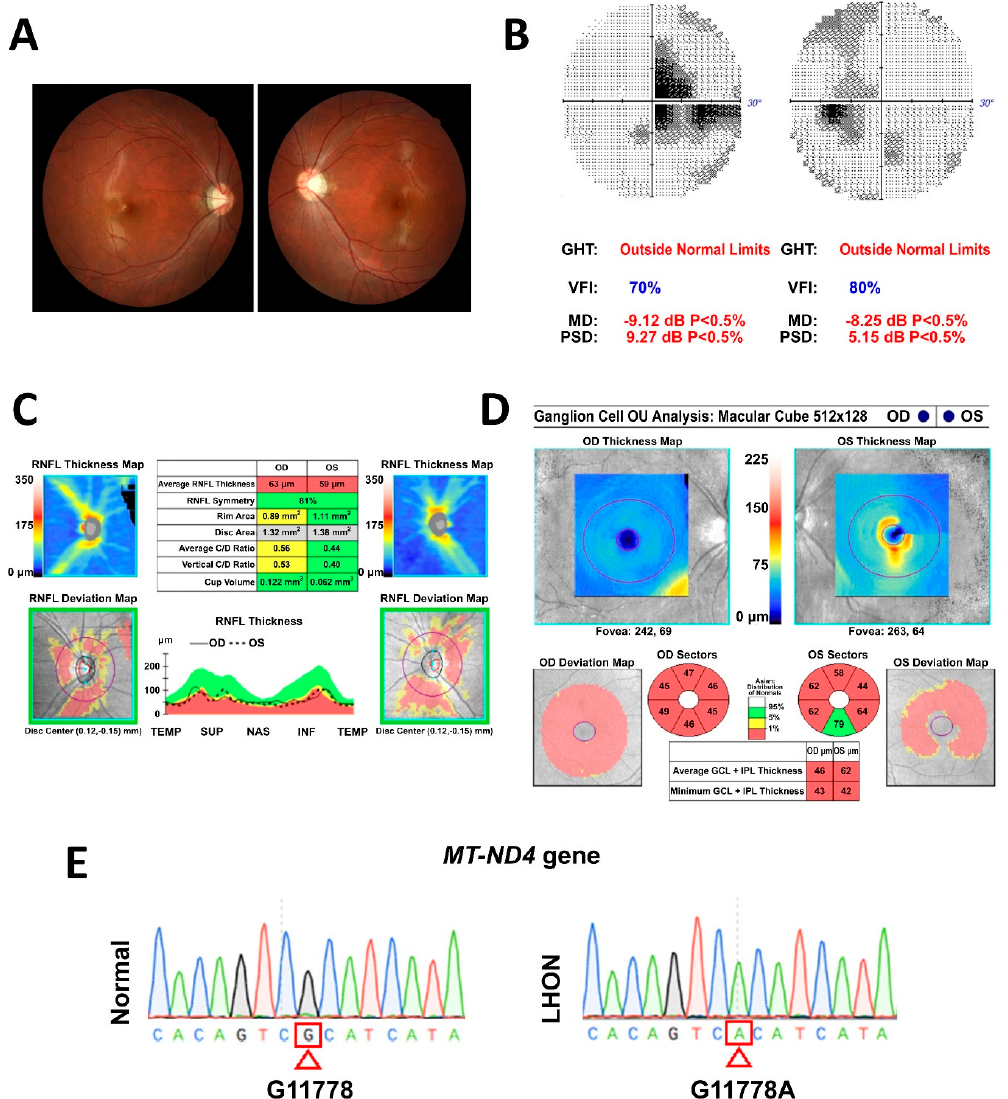
Figure 1. Characterization of Leber’s hereditary optic neuropathy (LHON) patient. ( A ) Fundus photography showing temporal pallor of optic disc in both eyes. ( B ) Visual filed test showing bilateral central scotoma with mean deviation of − 9.12 dB in the right eye and of − 8.25 dB in the left eye. ( C ) Optical coherence tomography showing decreased peripapillary average retinal fiber layer thickness of 63 µ m and 59 µ m in right and left eye, respectively. ( D ) Optical coherence tomography showing thinning of macular ganglion cell layers in both eyes. ( E ) DNA sequencing demonstrating the presence of G11778A mutation in patient’s mtDNA.